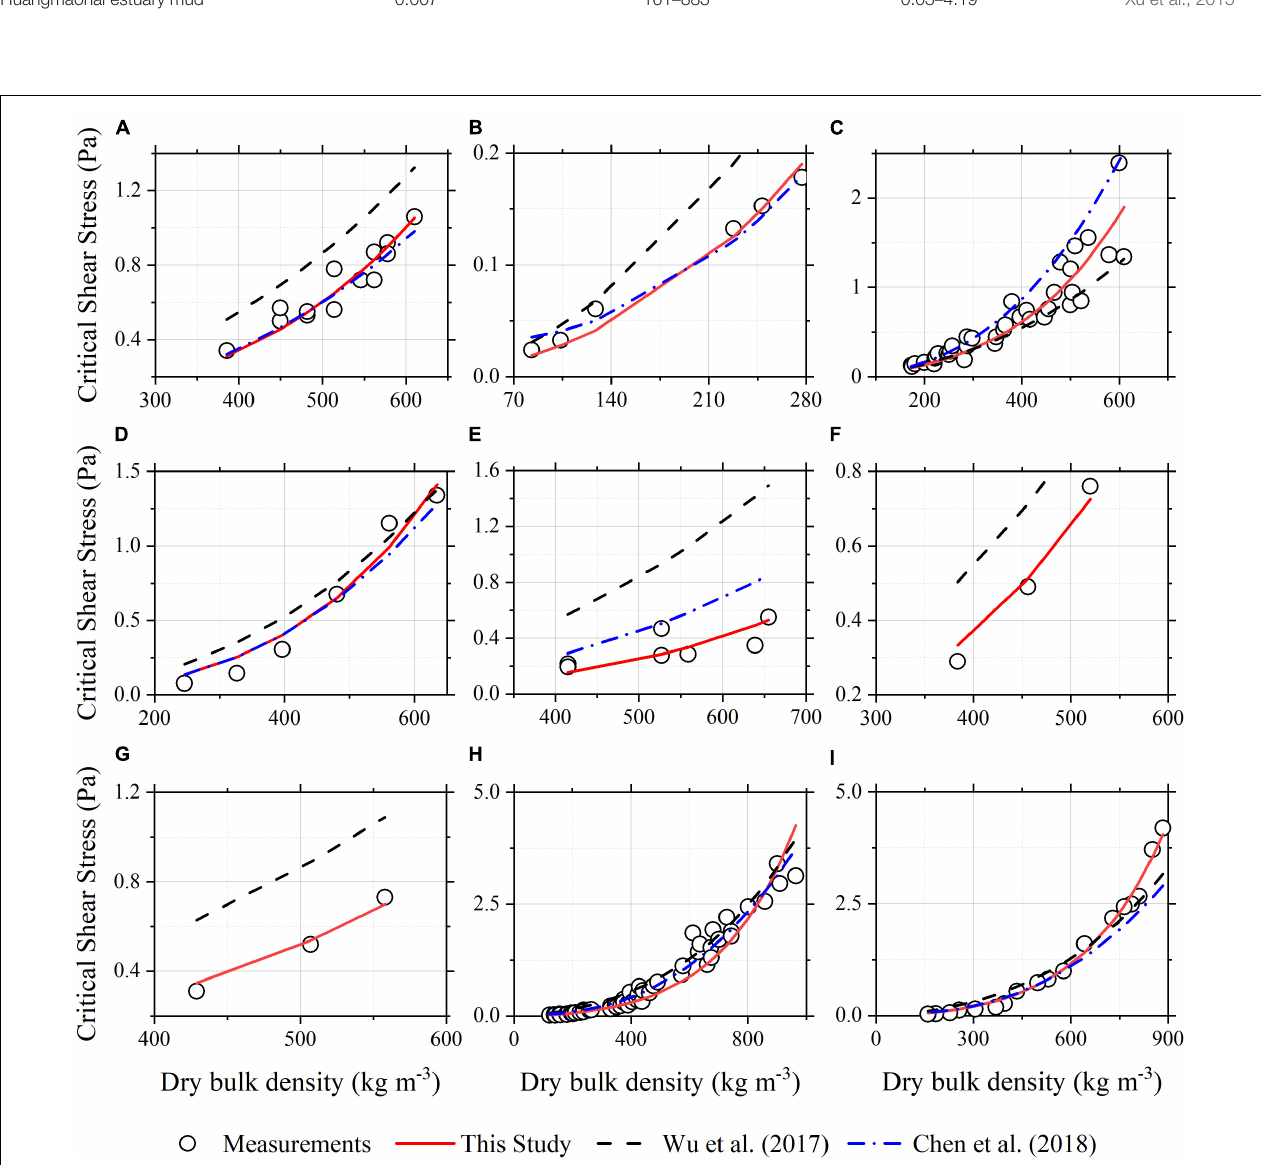
FIGURE 8 | The comparisons of Eq. (23) and the formulae of Wu et al. (2017) and Chen et al. (2018) with the measured critical shear stresses: (A) pure kaolinite; (B) Chikugo estuary mud; (C) Lianyungang port mud; (D) Lianyungang waterway mud; (E) Hangzhou Bay mud; (F) Zhejiang coastal mud (Location 1); (G) Zhejiang coastal mud (Location 2); (H) Tianjin New Port mud; and (I) Huangmaohai Estuary Mud.